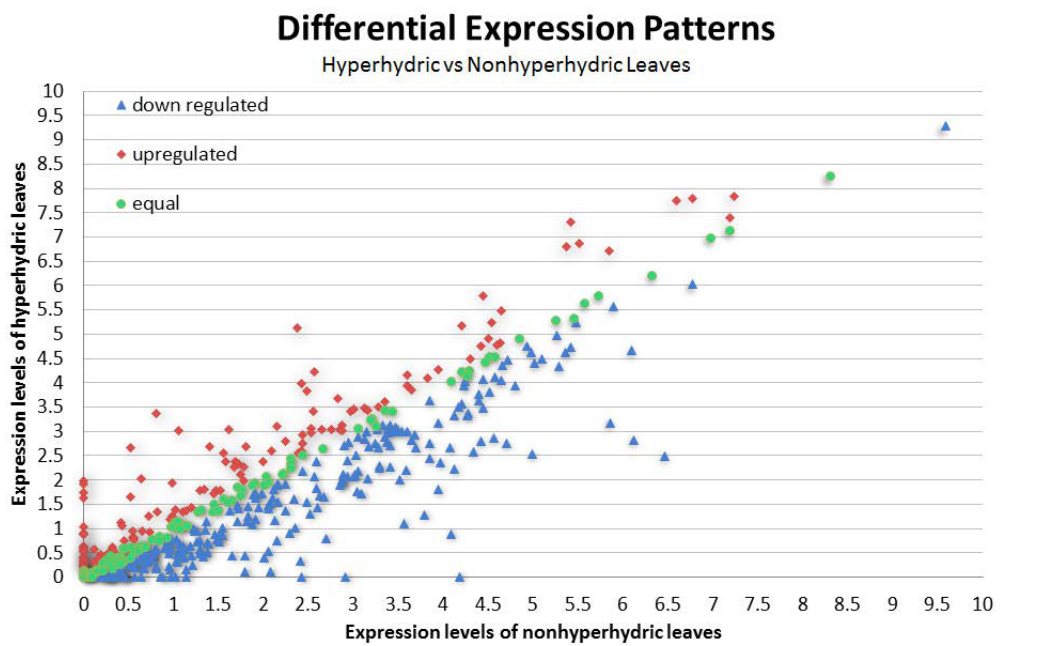
Figure 3: Scatter-plot demonstration of differentially expression patterns of miRNA precursors between hyperhydric and non-hyperhydric peach